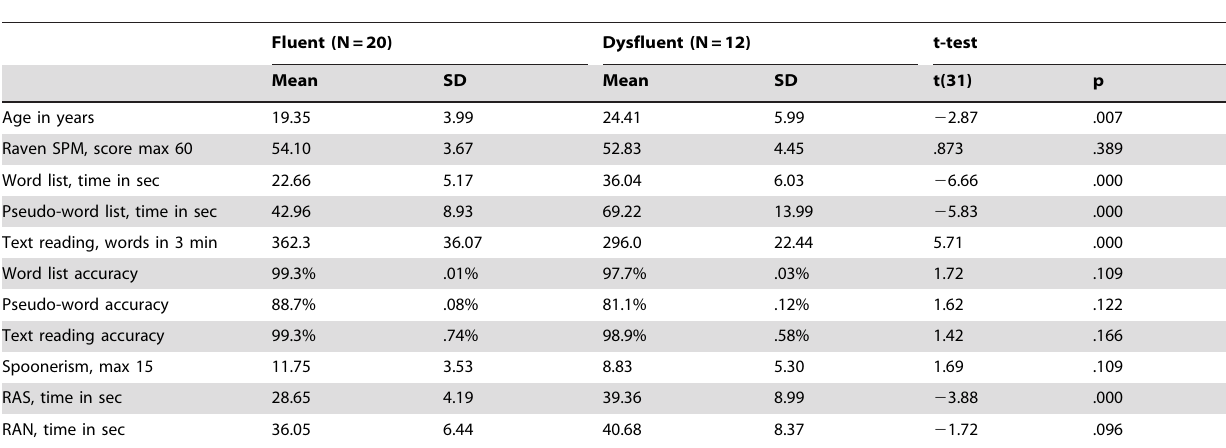
Table 1. Demographic data of Age, Reading and Related Skills, and Cognitive Ability for Fluent and Dysfluent Reader